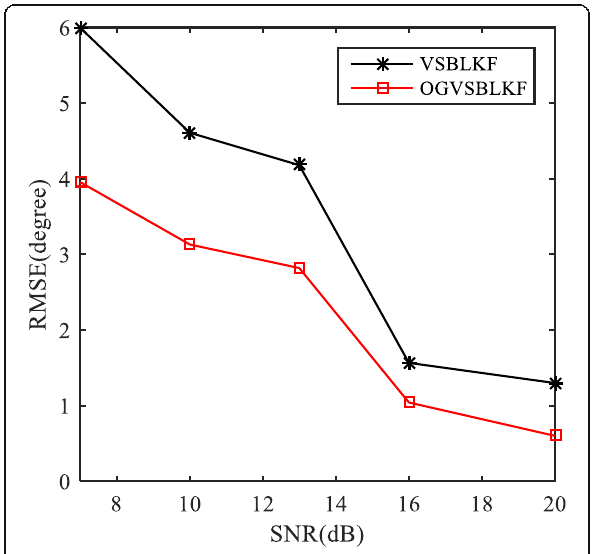
Fig. 13 RMSE as a function of SNR in the off-grid model